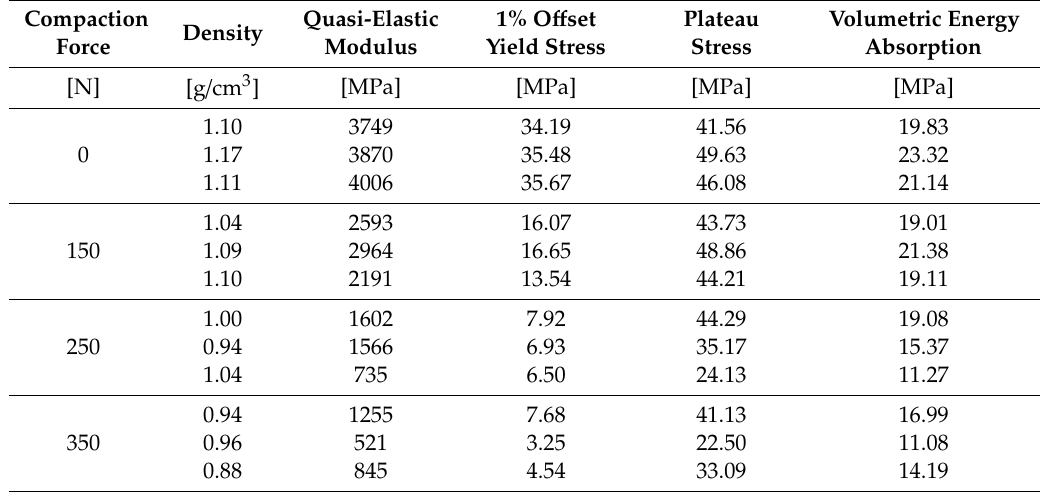
Table A2. E ff ective mechanical